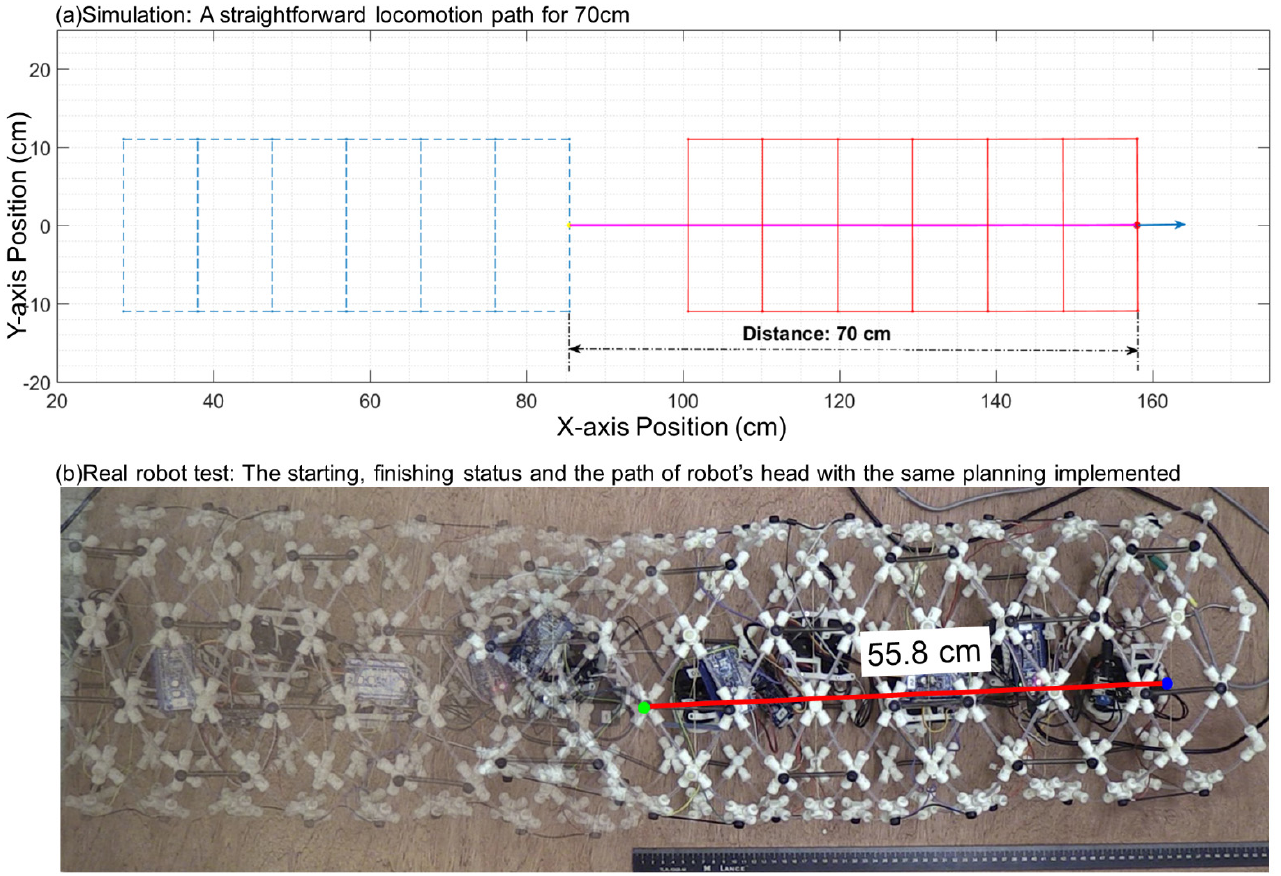
Figure 13. ( a ) a straightforward locomotion path for a 70 cm straightforward generated by the simulation. ( b ) Start (green dot) and finish (blue) position of a real six segment worm-like robot applying the same algorithm. The red line shows the total movement (55.8 cm), which is 80% of the simulation result.